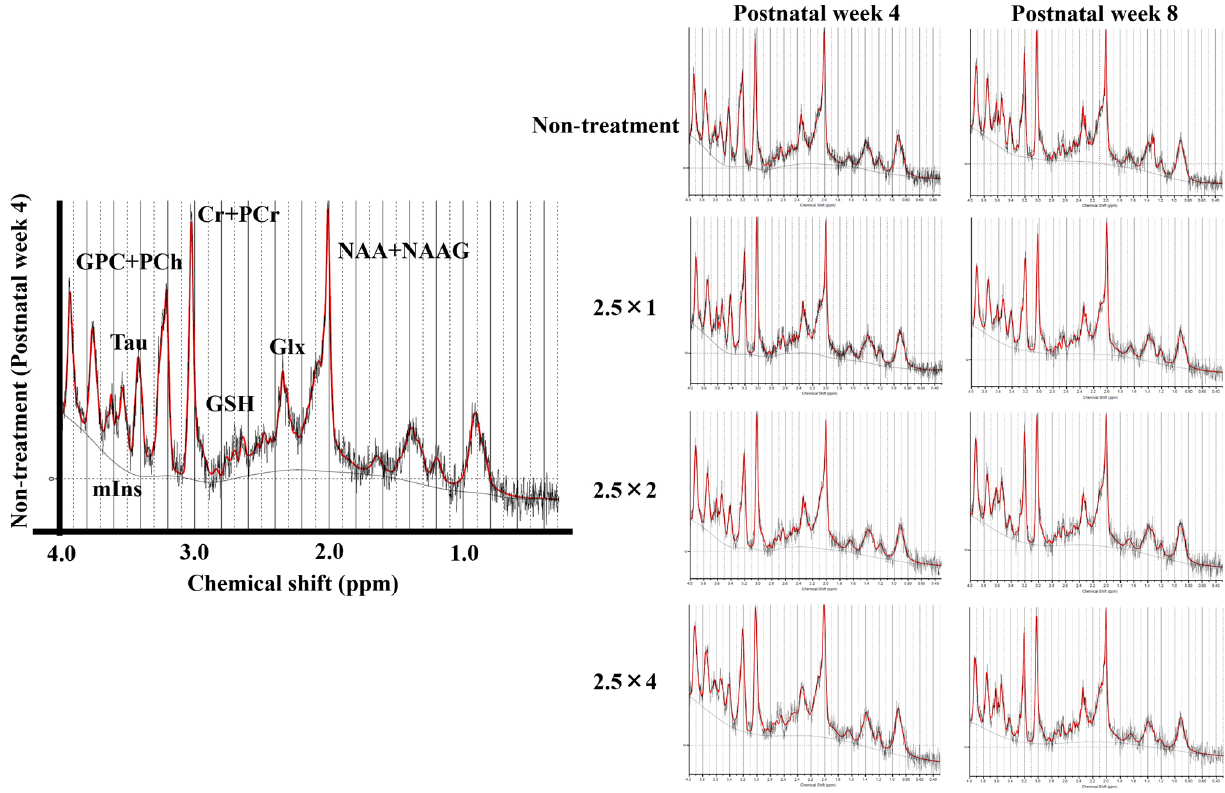
Figure 5. MR spectrum of 4- and 8-week-old rats analyzed using LCmodel.